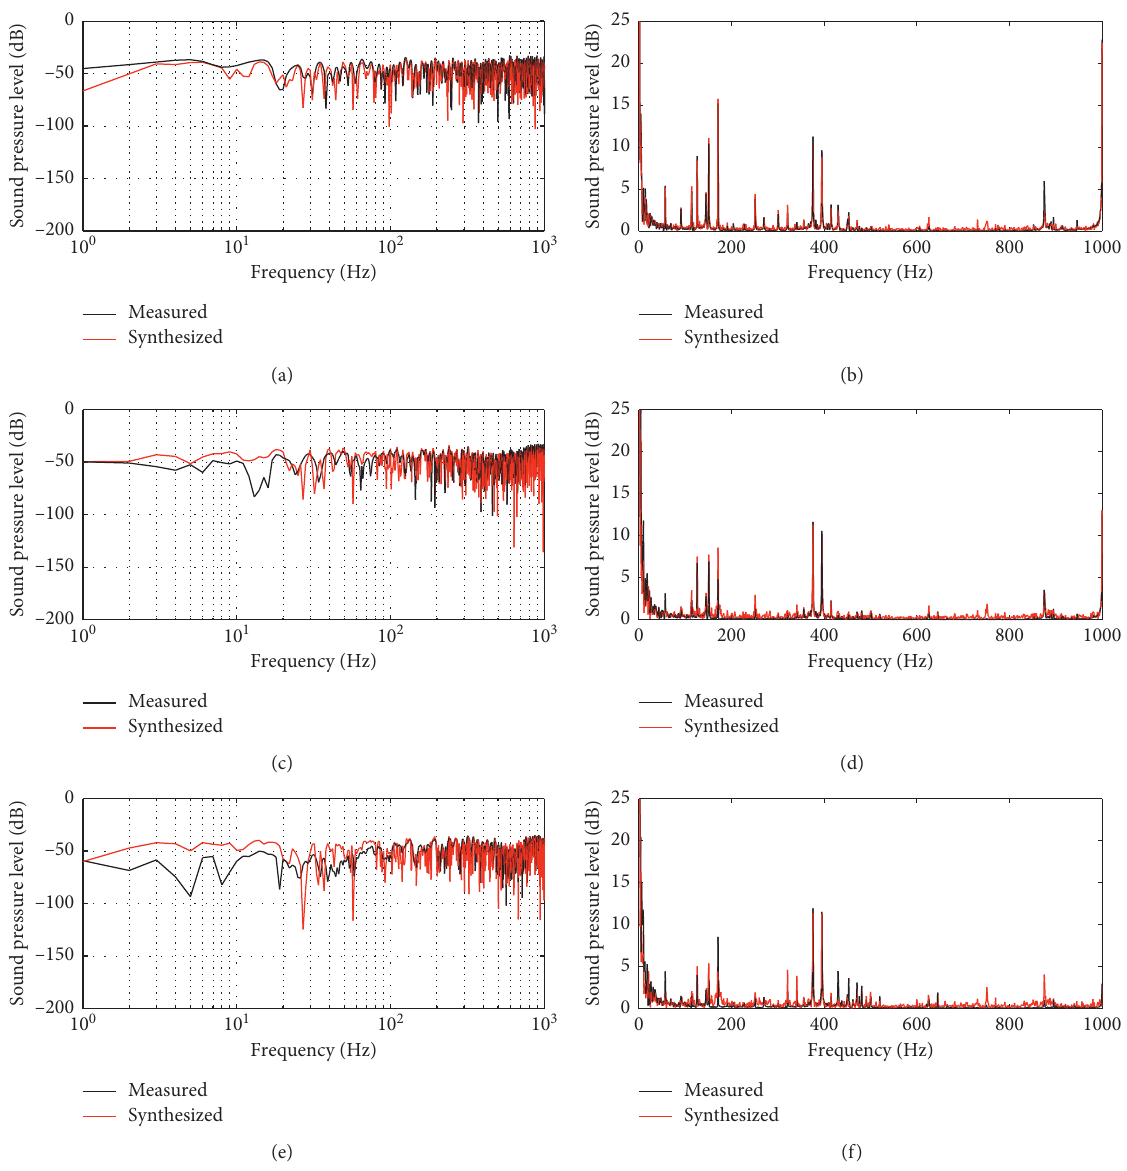
Figure 29: Response synthesis for measurement 1: (a) d � 240mm; (b) d � 240mm; (c) d � 750mm; (d) d � 750mm; (e) d � 1260mm; (f) d � 1260mm.